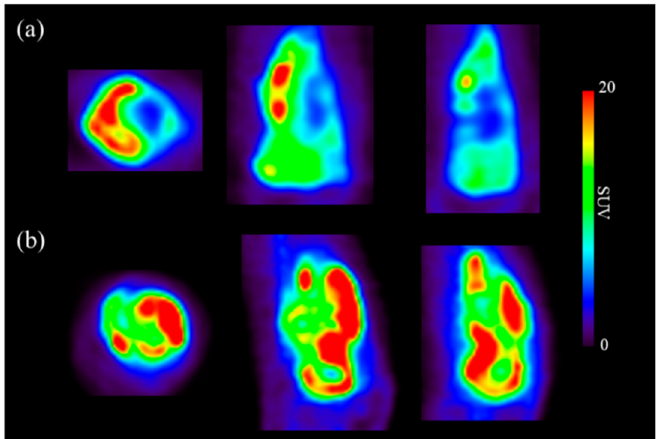
Figure 2. Transverse, coronal, and sagittal sections from osteosarcoma 18 F-FDG PET/CT images. ( a ) Images from a chemotherapy responder; ( b ) images from a chemotherapy non-responder.